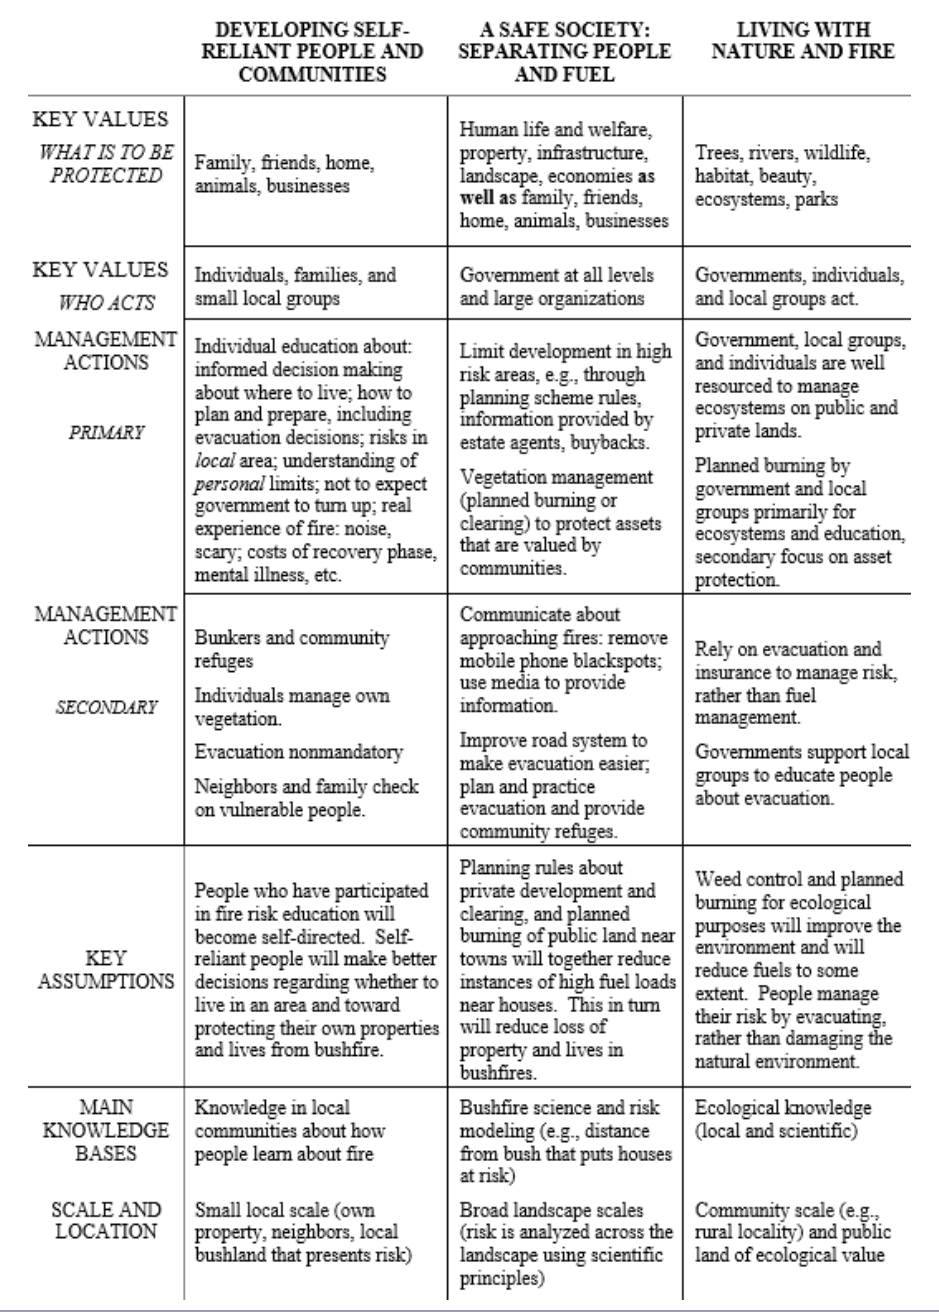
Fig. 5 . Three refined scenarios resulting from the participatory development process in